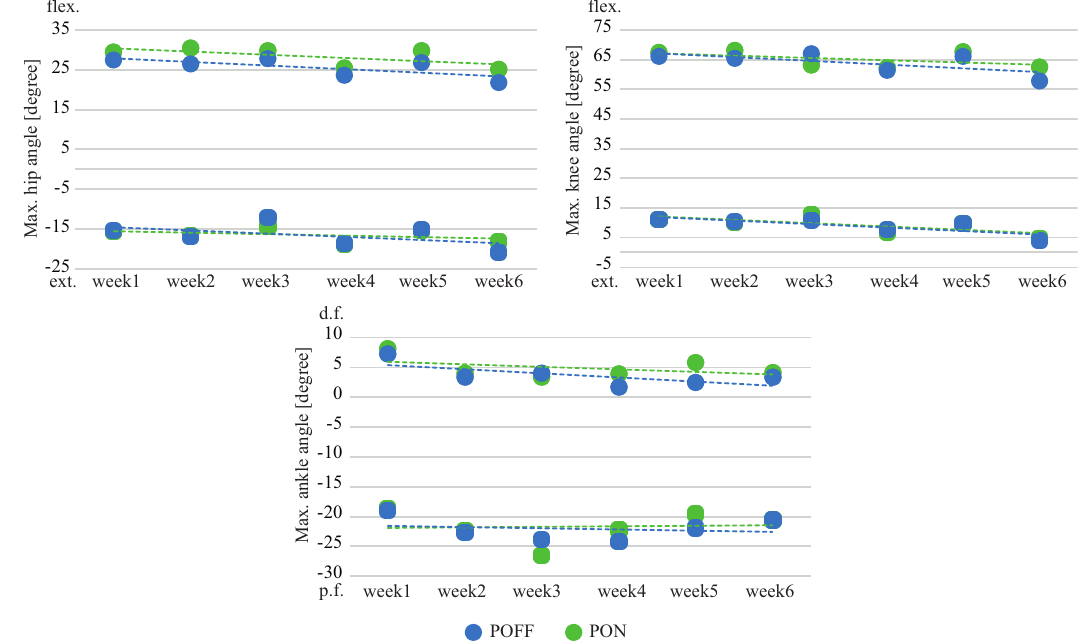
Figure 6. Comparison of average maximum joint angles of each week between the POFF condition and the PON condition. Here, flex.: flexion, ext.:extension, d.f.: dorsiflexion, and p.f.: plantar